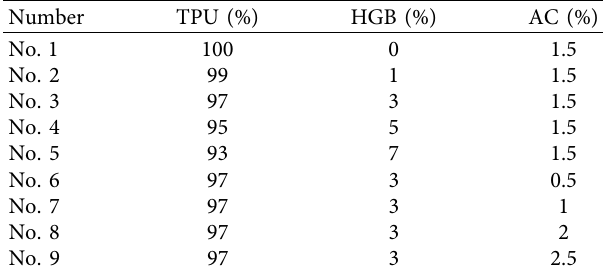
Table 4: Content of HGB/TPU foam